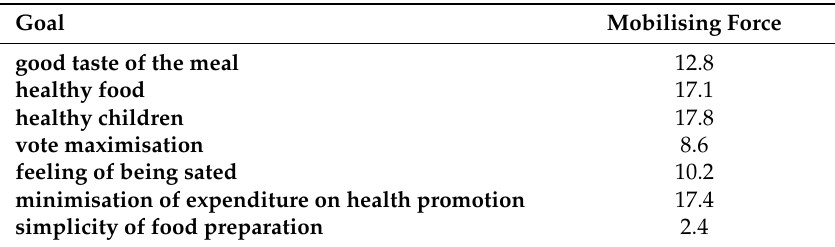
Table 6. Mobilising force of di ff erent